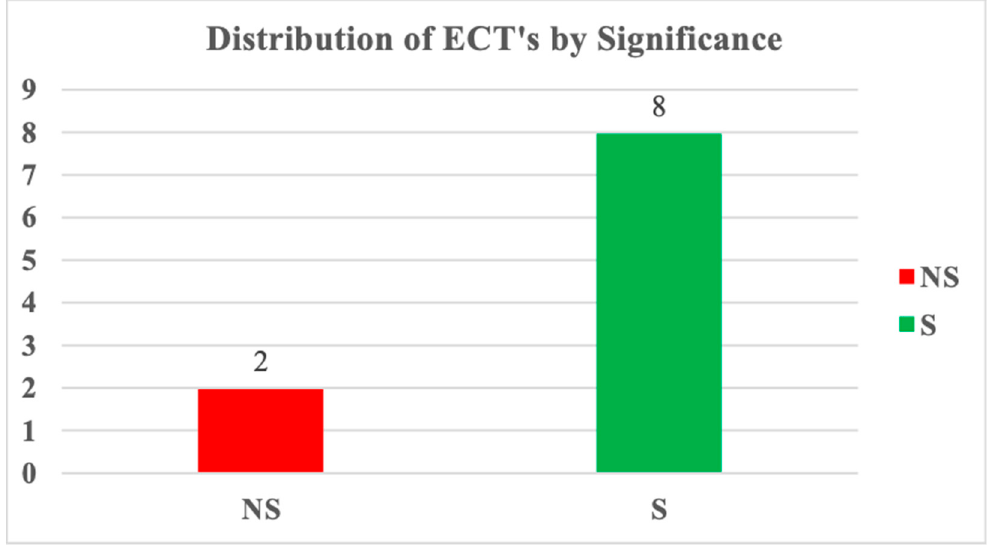
Figure 6. Short-run ECT’s. Source: World Bank data group. NS–No significant, S – Significant.